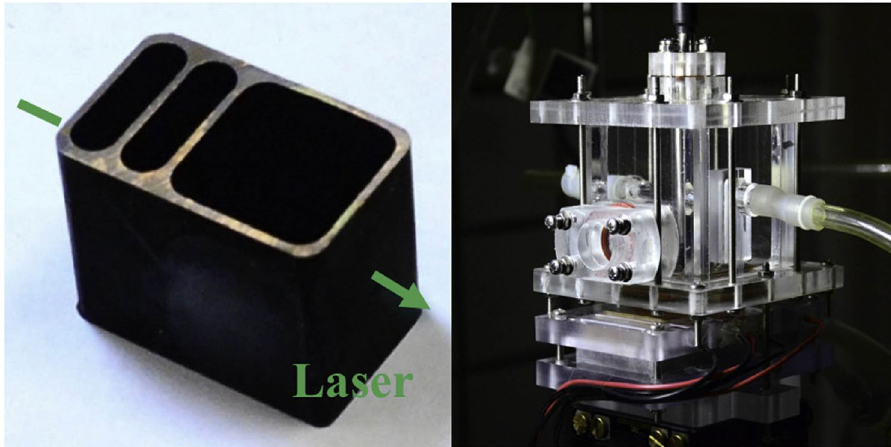
Figure 6. Pictures of experimental equipment.